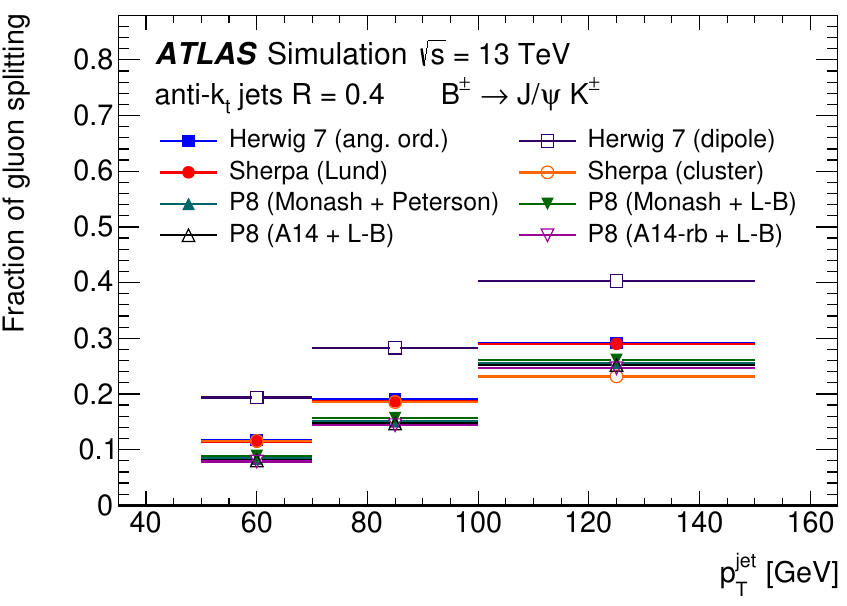
Figure 10 . Fraction of jets arising from gluon splittings g → b different MC